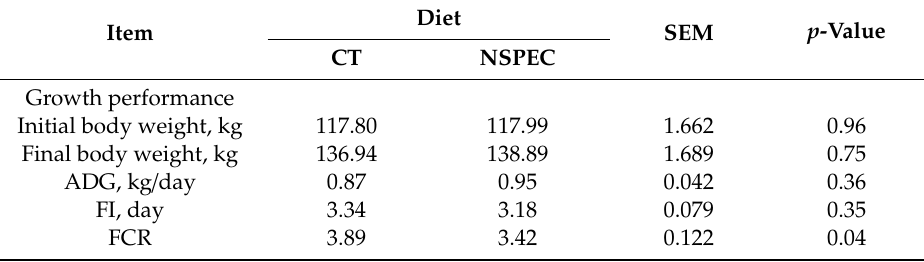
Table 2. E ff ect of the optimal NSPEC on growth performance and nutrient digestibility in finishing pigs 1